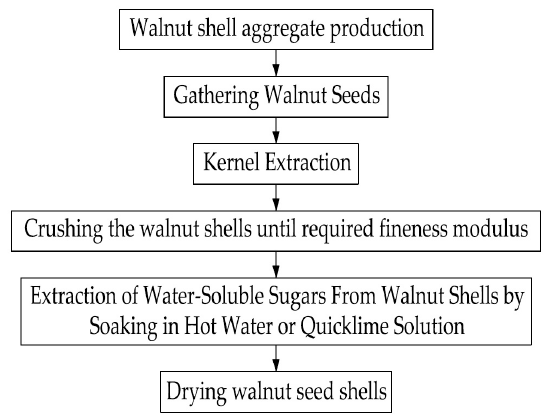
Figure 2. Walnut-shell-processing process.